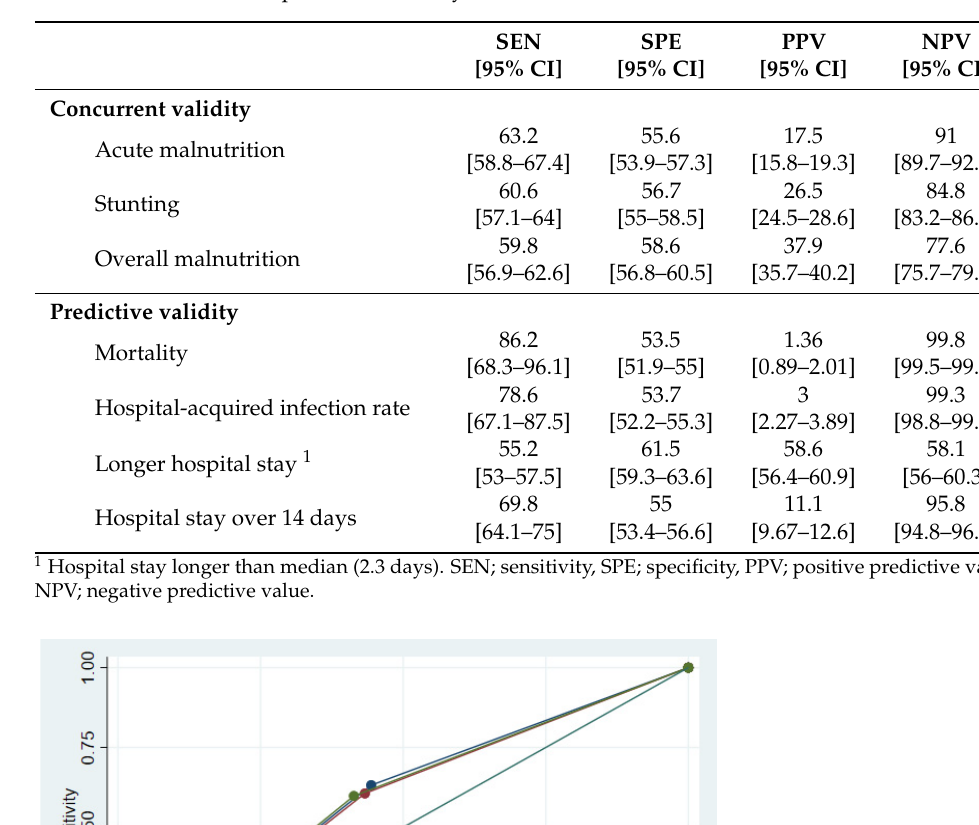
Table 3. Concurrent and predictive validity of STRONGkids.